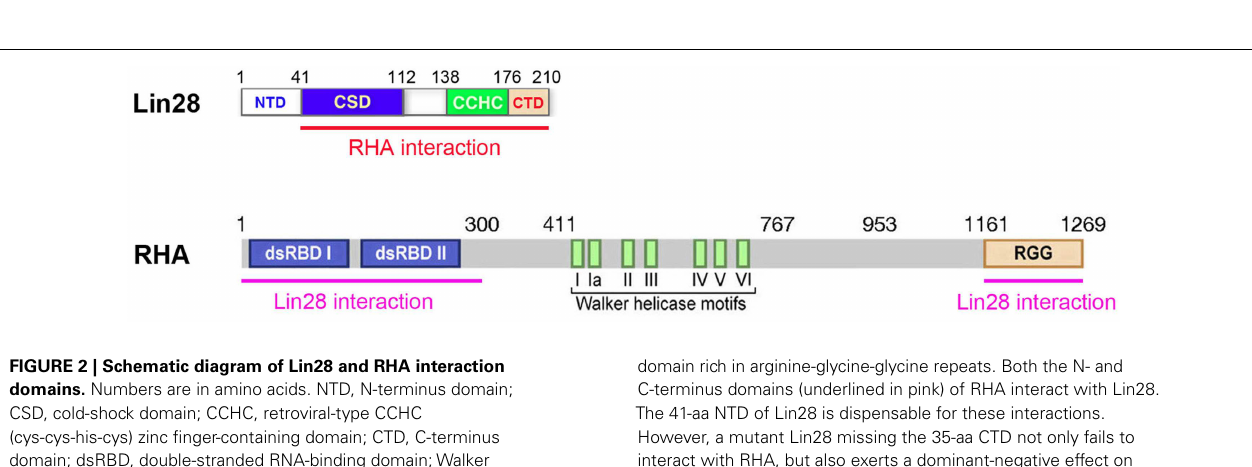
domain rich in arginine-glycine-glycine repeats. Both the N- and C-terminus domains (underlined in pink) of RHA interact with Lin28. The 41-aa NTD of Lin28 is dispensable for these interactions. However, a mutant Lin28 missing the 35-aa CTD not only fails to interact with RHA, but also exerts a dominant-negative effect on Lin28-dependent stimulation of